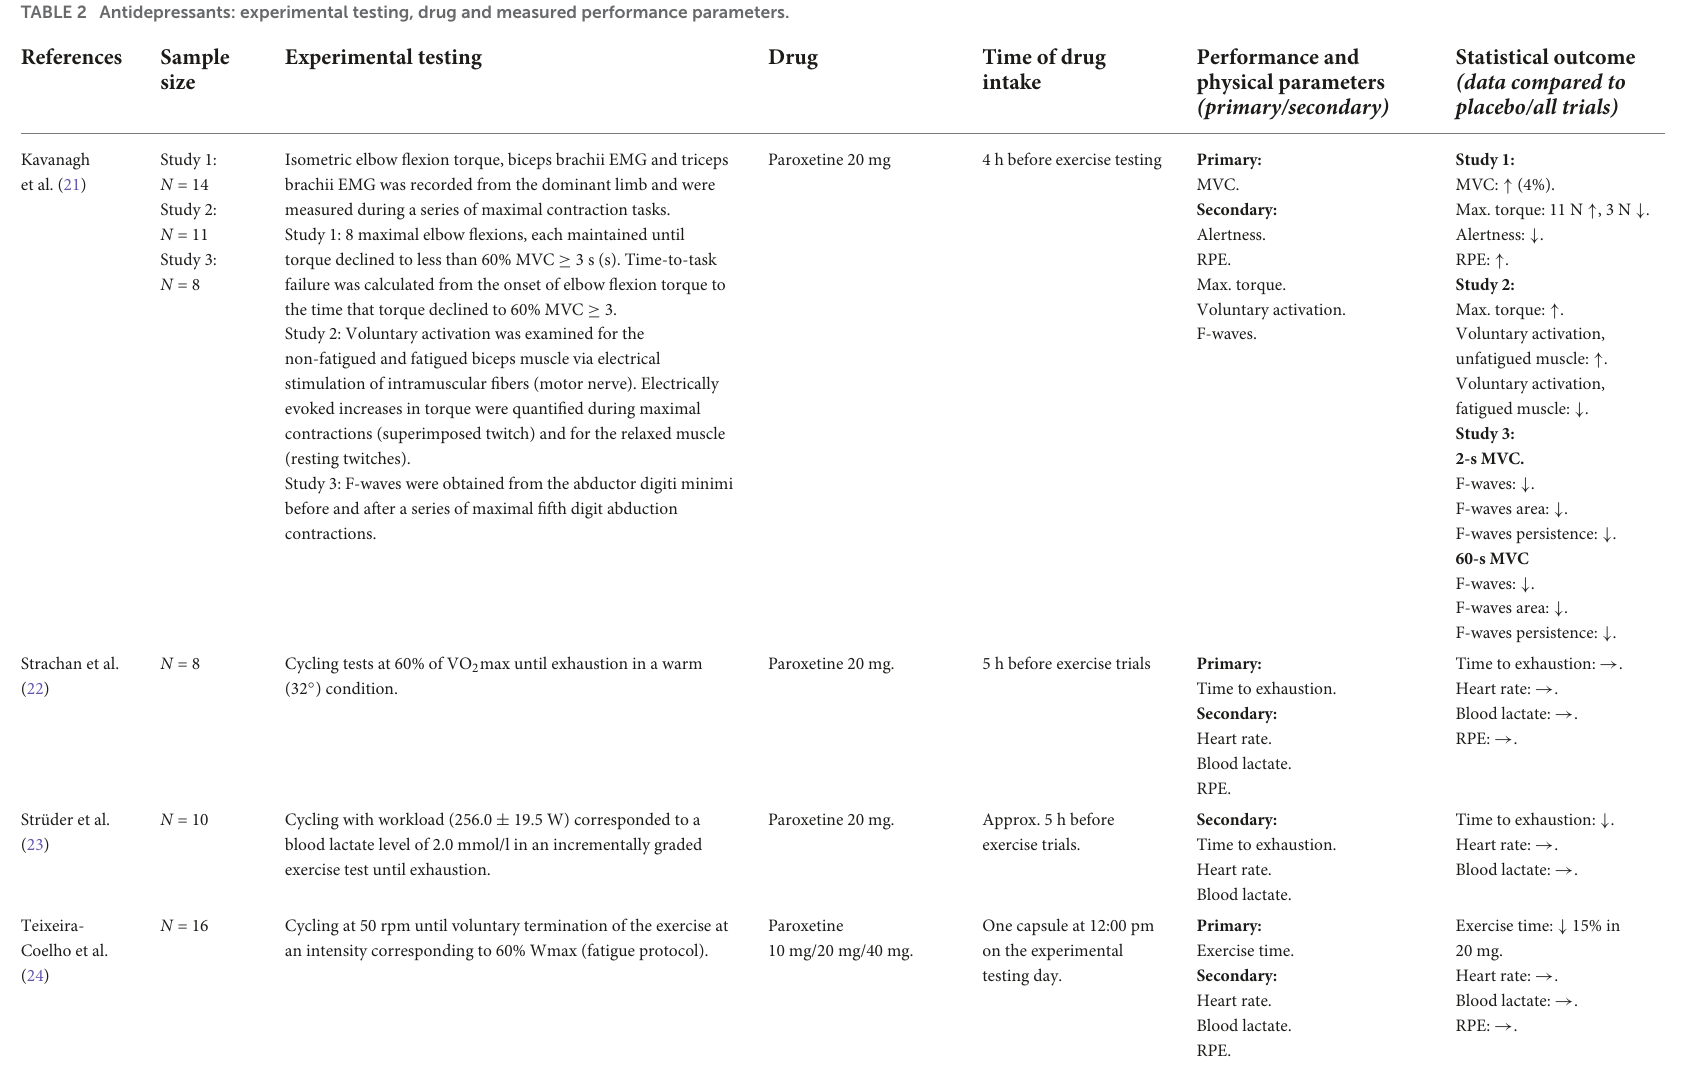
Drug Time of drug